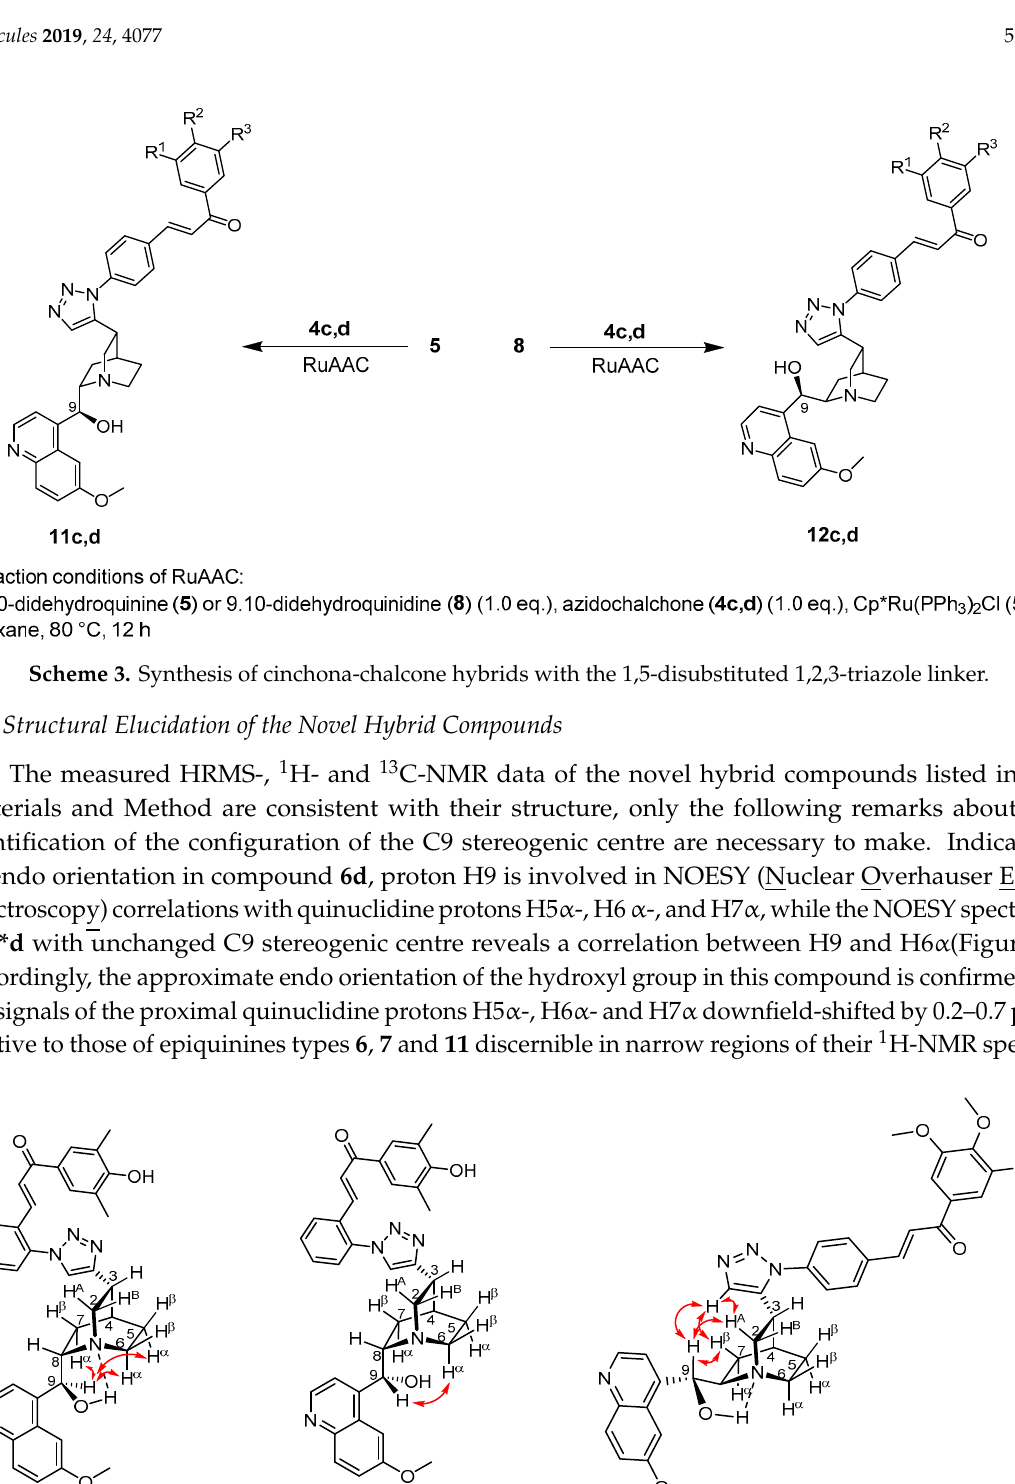
Figure 1. Diagnostic NOE (Nuclear Overhauser Effect) interactions detected in hybrid compounds 6d , 6*d and 12c.